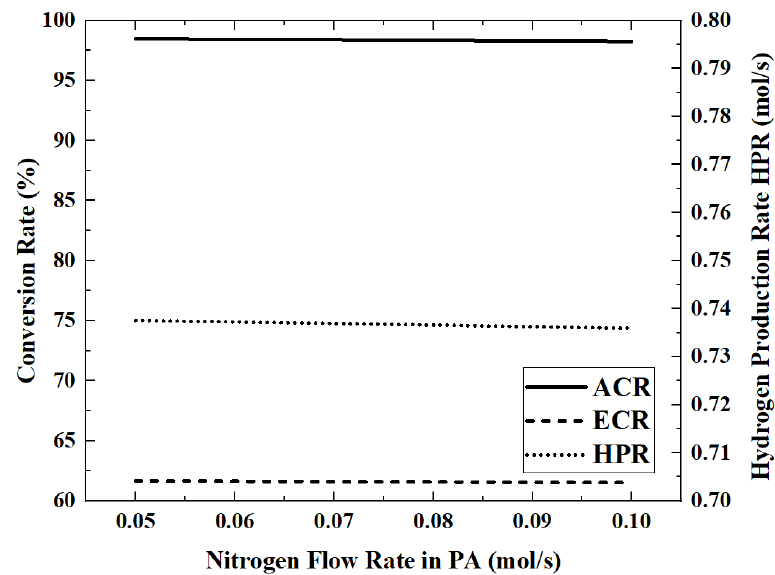
Figure 12. Effect of nitrogen flow rate on ACR, ECR and HPR.